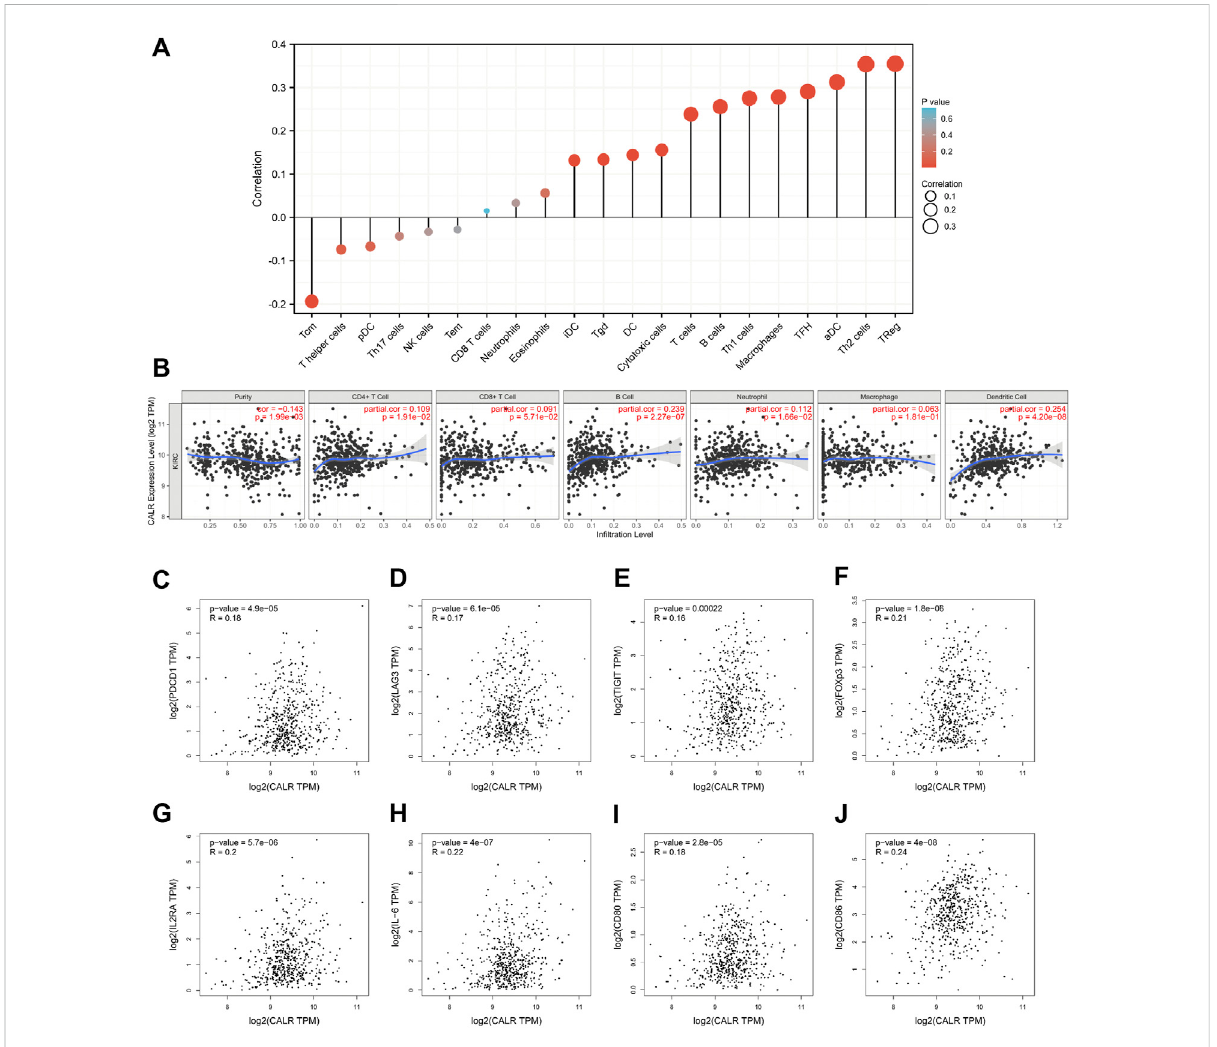
FIGURE 7 Correlation between CALR expression and immune in fi ltration in TCGA-KIRC. (A) Correlation between CALR expression and immune cells. (B) Correlation between CALR expression and immune cells after purity adjustment. (C – J) Correlation between CALR expression and immunomodulatory